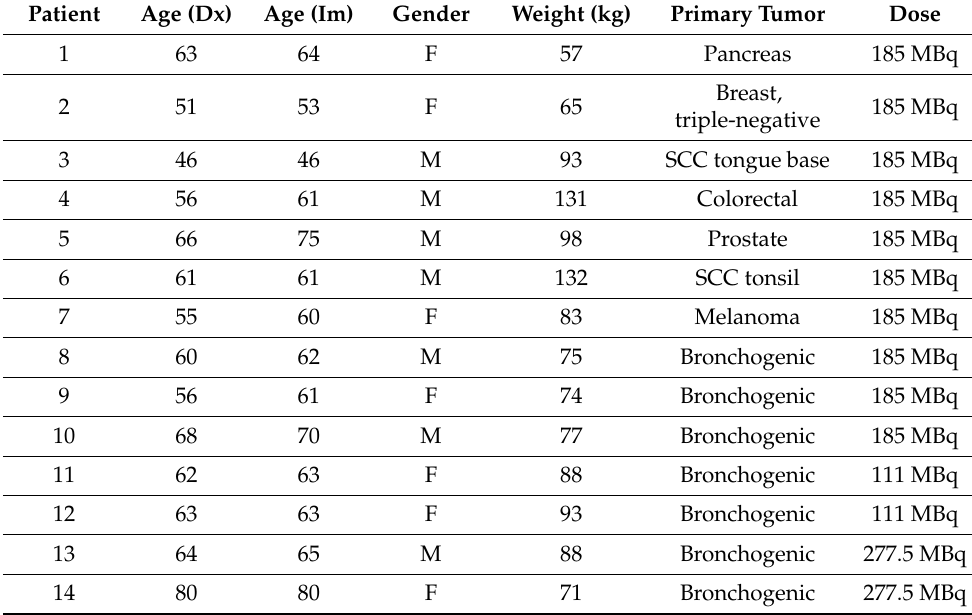
Table 1. Demographic and imaging data for the [ 124 I]I-NM404